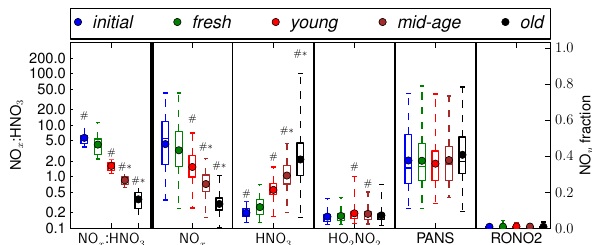
Fig. 1. Nitrogen partitioning of fresh, young, midage and old age categories demonstrates influence of chemical aging. Each age cat- egory has been tested for statistical difference ( p < 0 . 0001) from the preceding age category ( ∗ ) and fresh